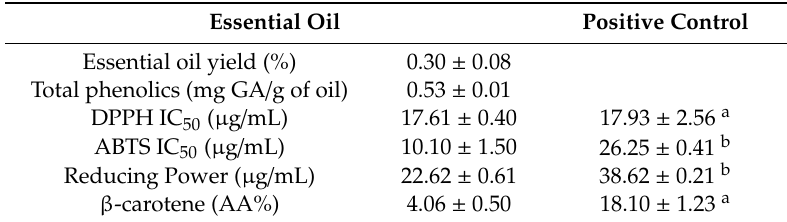
Table 4. Total phenolics, flavonoids, and antioxidants in the leaf essential oil extracted from Sideritis perforata